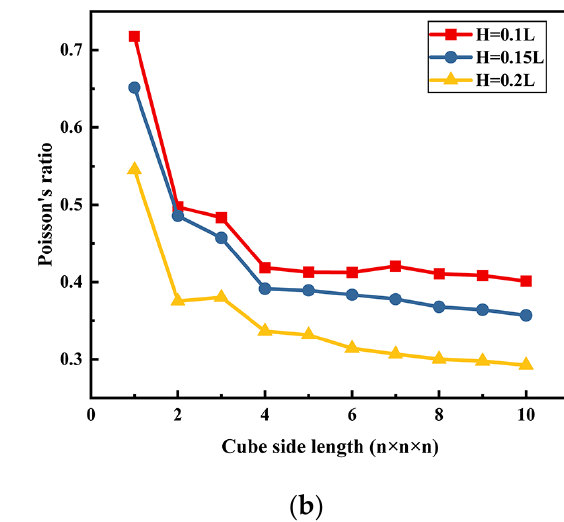
Figure 8. Mechanical properties of the compliant lattice with different S-shaped heights: ( a ) The relationship between the elastic modulus and the cube side length (with H = 0.1–0.2 L); ( b ) The relationship between the Poisson’s ratio and the cube side length (with H = 0.1–0.2 L).